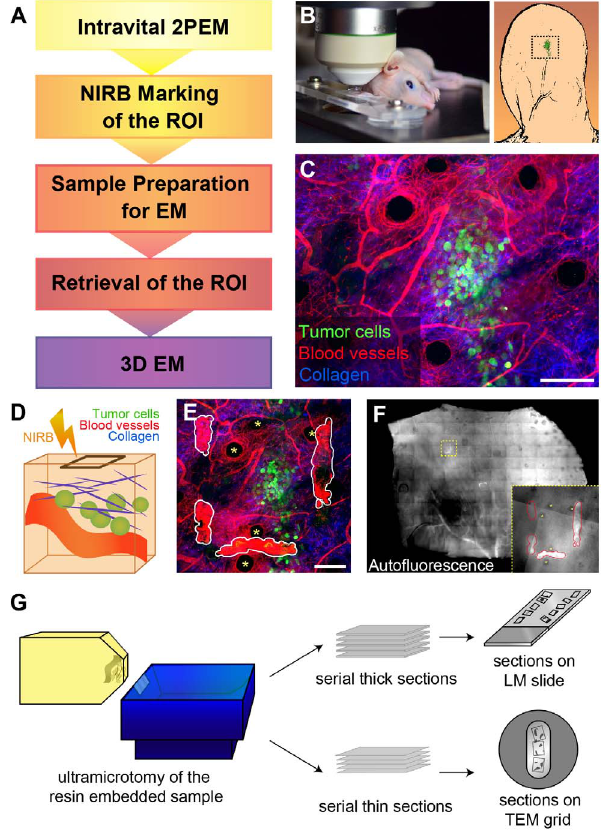
Figure 1. Outline of the Correlative Workflow. A. The flowchart lists the general steps involved in the correlative workflow. B. Left panel: installation of the anesthetized mouse on the LM stage. The ear with the transplanted fluorescent tumor cells (right panel, cartoon) is mounted in a custom-built holder. C. Z-projection of a typical 2PEM dataset obtained from the mouse ear that was injected with GFP-expressing tumor cells (green). SHG signal of the collagen fibers is shown in blue. Evans Blue stains blood vessels and is depicted in red. Scale bar: 100 m m. See Movie S1. D. Cartoon of the NIRB process representing the imaged volume containing a vessel (red), collagen fibers (blue), and tumor cells (green). Our NIRB-procedure entails drawing a frame at the surface of the skin with a high-powered laser, above and away from the ROI. The imaged volumes presented in this work were in between 60 and 200 m m in depth and ranging from 270 to 440 m m in xy. E. Following NIRB, the same volume is imaged again with 2PEM. The NIRB marks visible in this z- projection are traced in white. Scale bar: 100 m m. Asterisks point to hair follicles. See Movie S1. F. After chemical fixation of the mouse ear sample, NIRB markings remain temporarily autofluorescent and their location can be mapped. Asterisks pointing to hair follicles (as in E). G. Following EM processing, the embedded sample can be trimmed and sectioned by ultramicrotomy. Serial thick sections (500 nm) are placed on glass slides to be imaged by light microscopy (‘sections on LM slide’). Serial thin sections (60 to 240 nm) are mounted on slot grids (‘sections on TEM grid’) allowing for TEM observation and/or electron